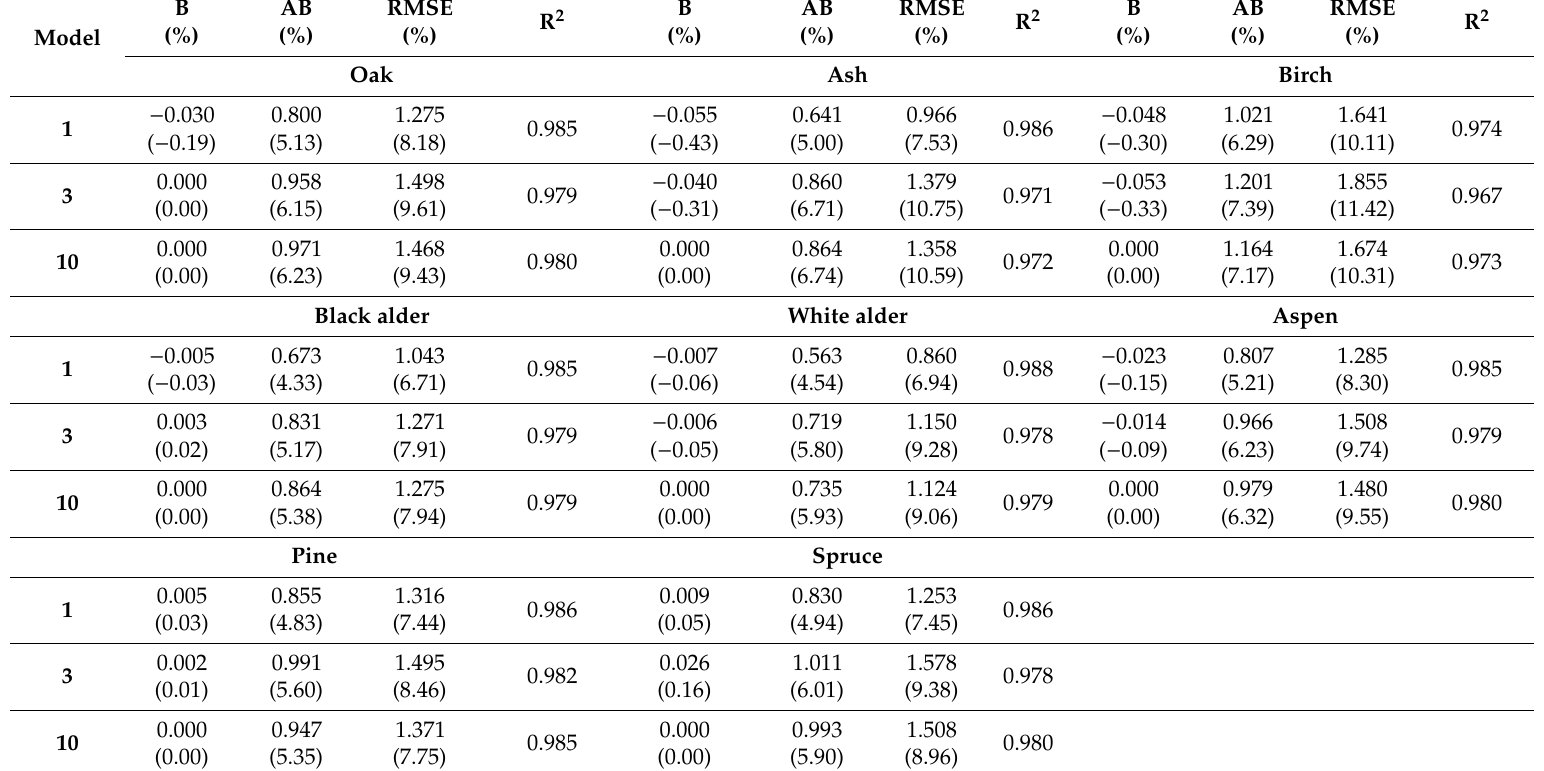
Table 5. Statistical measures for all fitted stem diameter